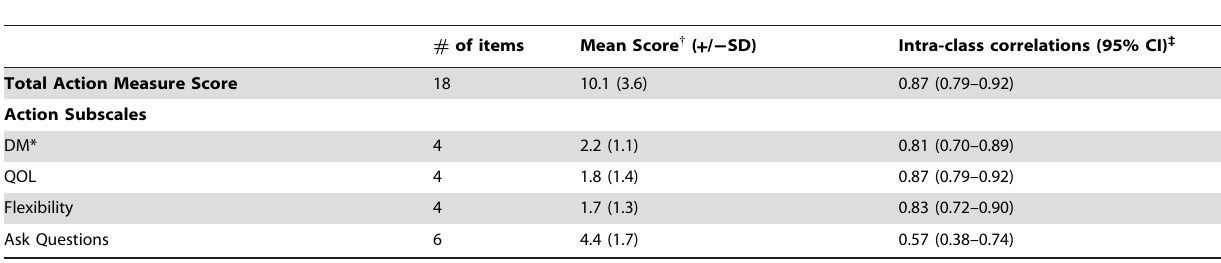
Table 5. Advance Care Planning Engagement Survey – Action Measures: Reliability, & Descriptive